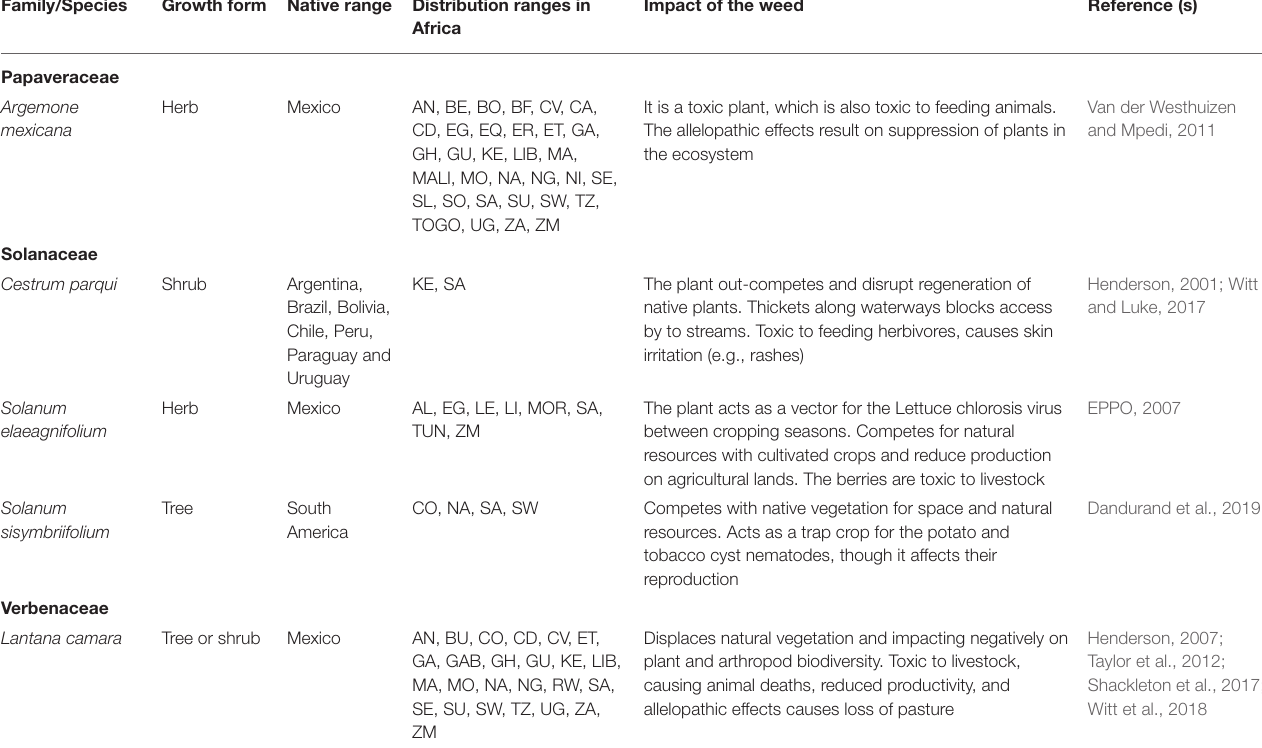
TABLE 1E | Published reports on the impact of some invasive alien plants in sub-Saharan